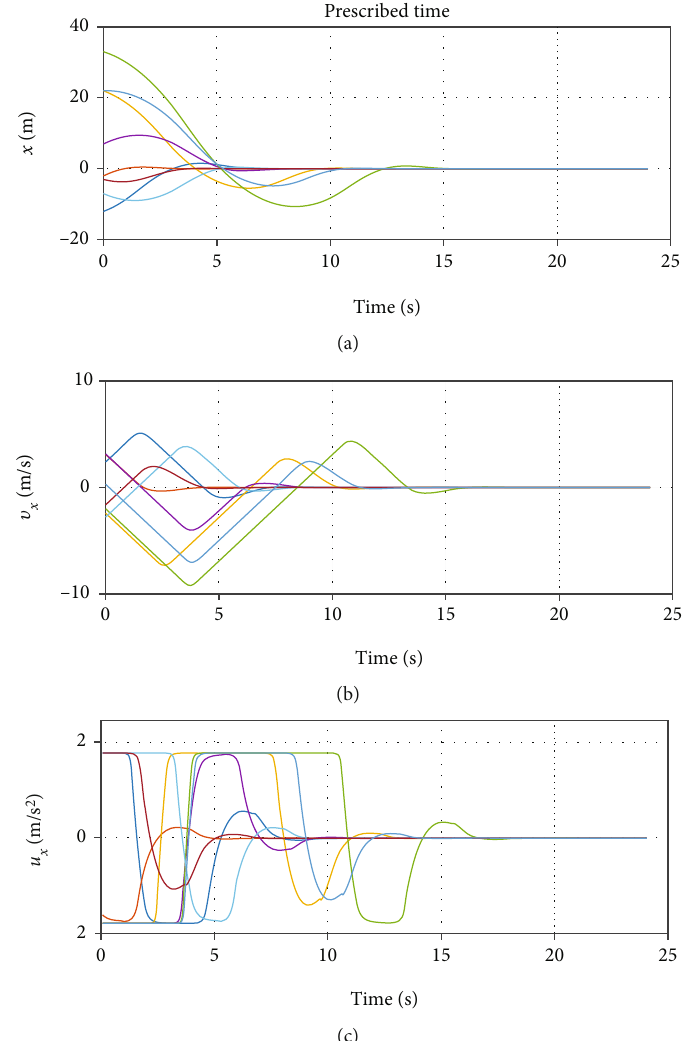
Figure 6: The x -axis (a) position error, (b) velocity error, and (c) control input curves of the fi nite-time convergence controller